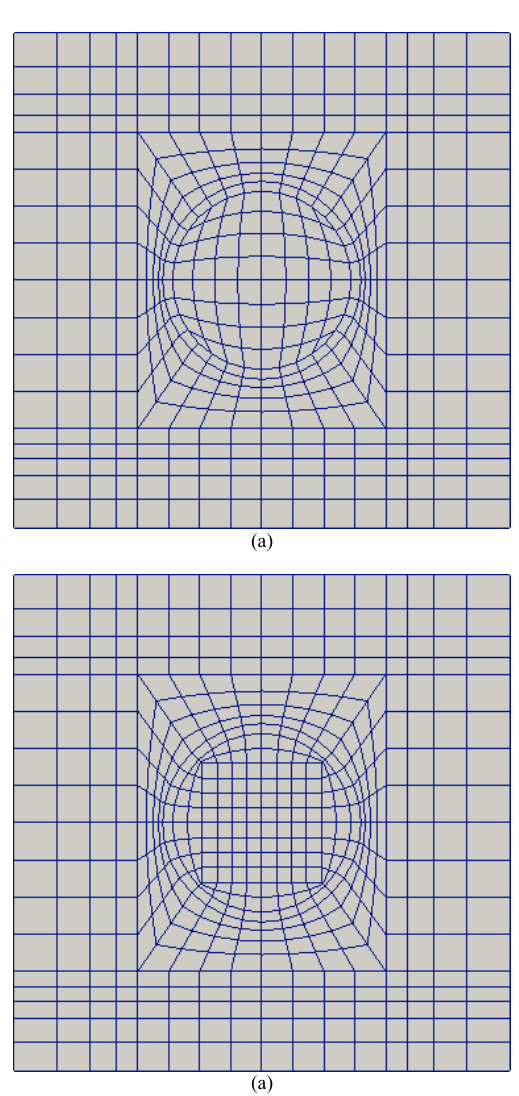
Fig. 5. Examples of structural